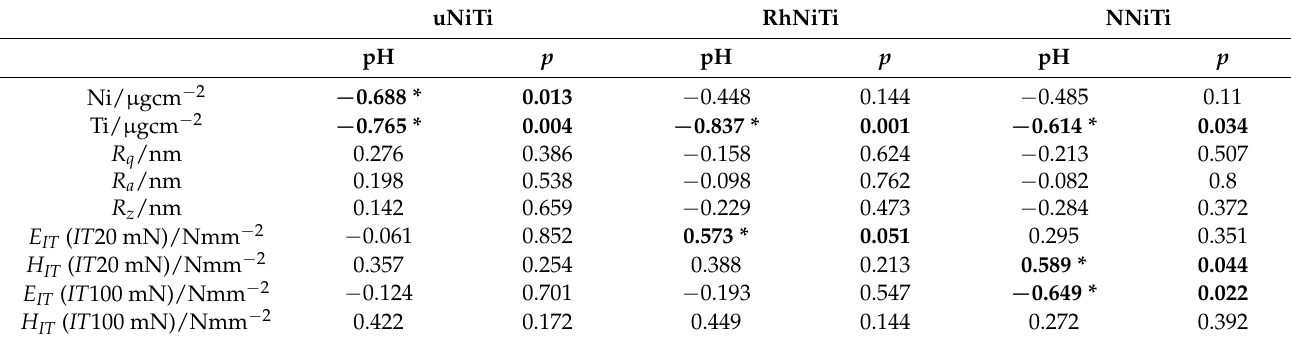
Table 4. Pearson correlations between the released amount of nickel (Ni) and titanium (Ti) ions; the arithmetic average surface roughness R a ; the RMS roughness R q ; the maximum height of the asperities R Z ; the nanoindentation hardness ( H IT ) at 20 mN ( IT 20 mN) and 100 mN ( IT 100 mN); and Young’s modulus ( E IT ) at 20 mN ( IT 20 mN) and 100 mN ( IT 100 mN); and the pH of saliva, for the uncoated (uNiTi), rhodium-coated (RhNiTi), and the nitride-coated (NNiTi) nickel–titanium orthodontic